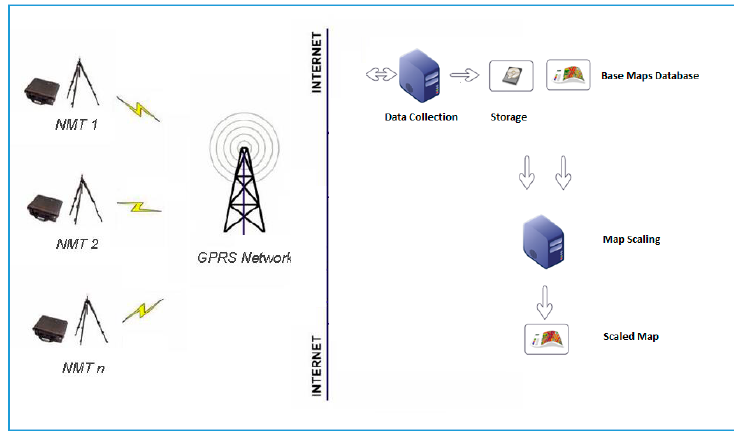
Figure 11. Schematic illustration of Dynamap working operation: data collection and storage from field noise monitoring terminals (NMTs), the scaling of the basic noise maps according to stored data, and the sum of scaled basic maps of each group g to produce the updated scaled noise map of the entire area. GPRS: General Packet Radio Service.